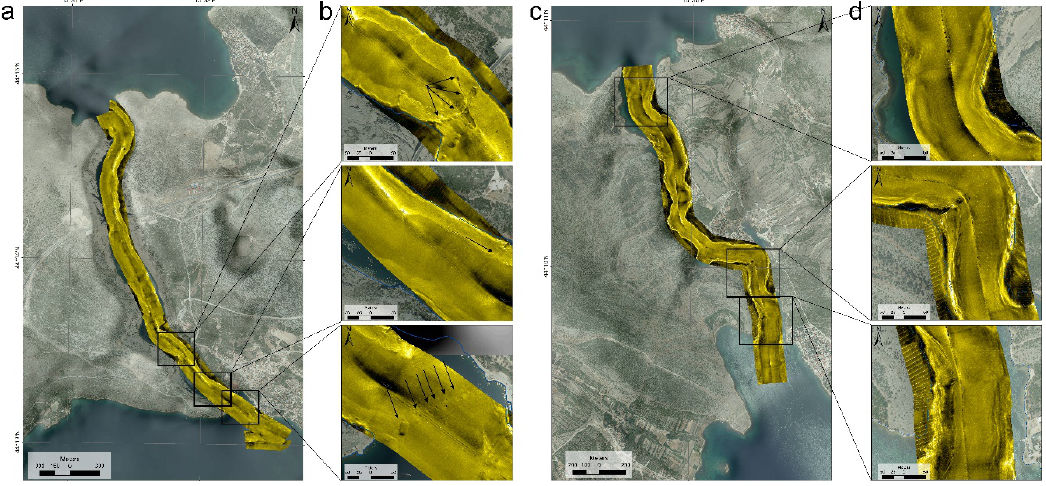
Figure 7. Side-scan sonar mosaic data showing the morphologic characteristics and anthropogenic impact in ( a ) the NZD channel; ( b ) enlarged details of the SSS mosaic showing the collapsed bridge construction (marked with arrows), the flat bottom with the pipeline crossing the channel, and the remains of the concrete slabs used to secure a floating bridge; ( c ) the KZD channel; ( d ) northern end with a flat bottom and rocky sides, a sharp bend with rocky outcrops, and the southern end of the channel with a flat bottom and several waveforms.